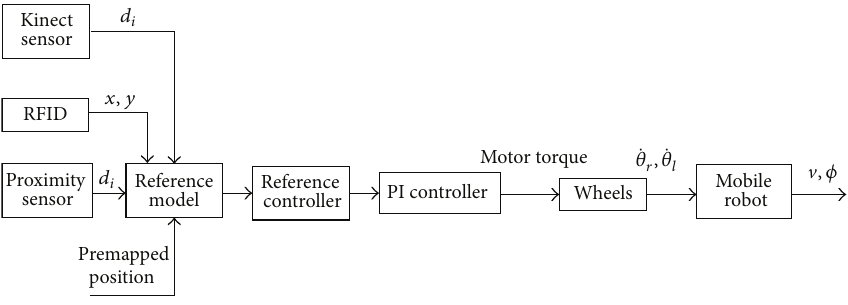
Figure 2: Block diagram of proposed control